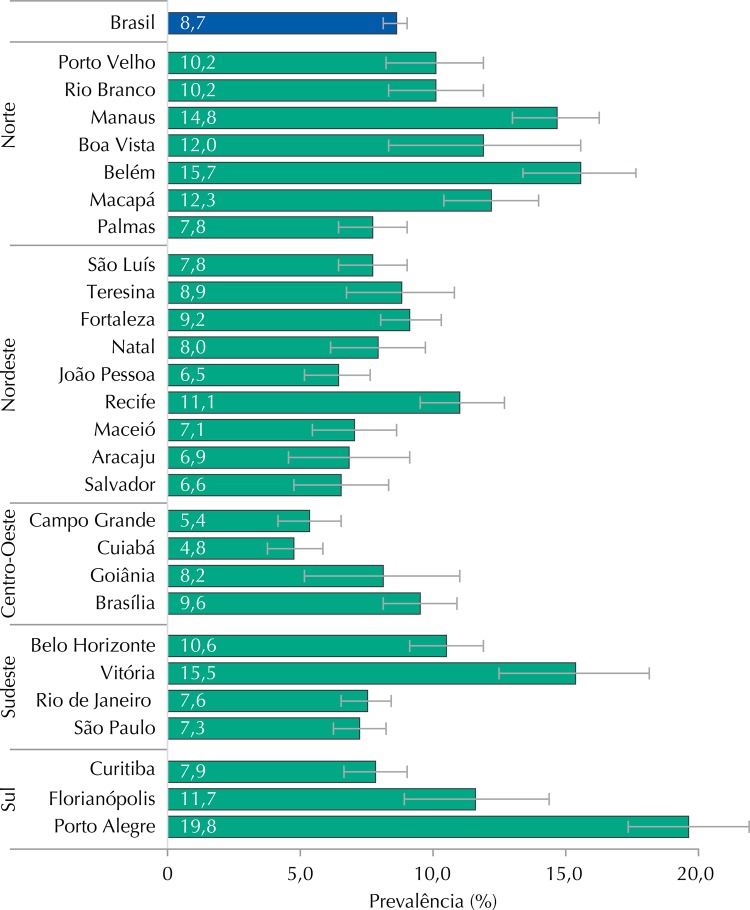
Prevalência (%) e IC95% de asma diagnosticada pelo médico em adolescentes de 12-17 anos segundo as capitais brasileiras. ERICA, 2013-2014.